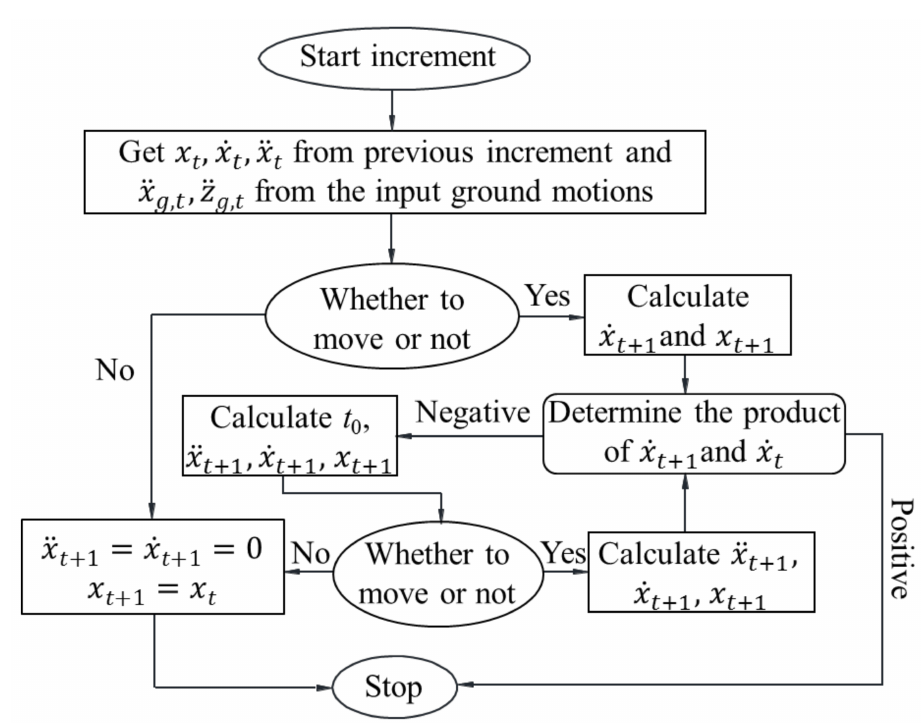
Figure 34. Flow chart of the numerical analysis.